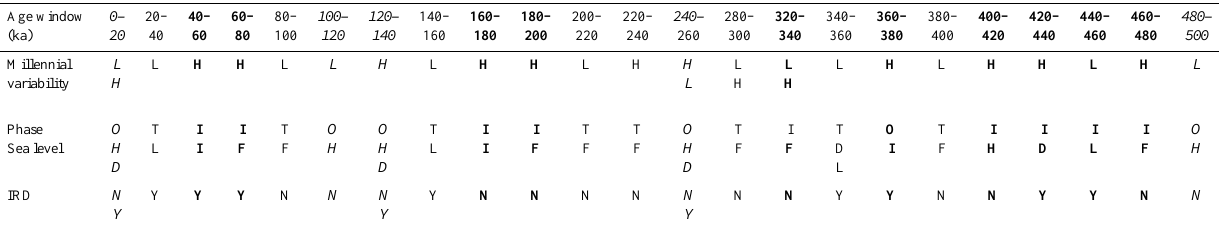
Millennial variability: H=high, L=low Phase with respect to precession: O=out of phase, T=transition, I=in phase Sea level: H=high, L=low, D=deglaciation, F=falling IRD: Y=yes,